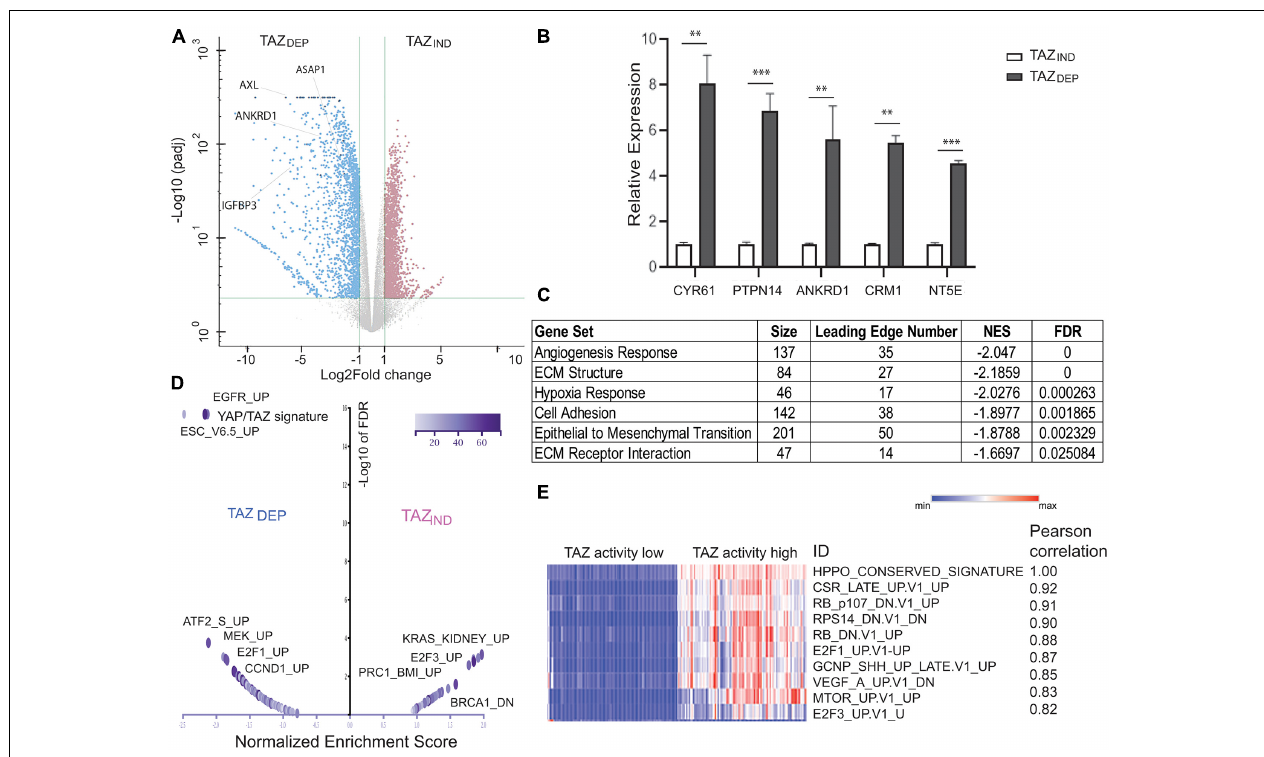
FIGURE 4 | Gene expression profiling for TAZ DEP and TAZ IND cells. (A) Volcano plot shows significant gene expression alterations between TAZ DEP and TAZ IND cells. (B) qRT-PCR experiment detection of canonical TAZ target expression in TAZ DEP and TAZ IND cells. Relative expression was normalized by GAPDH expression. Unpaired two-tailed Student’s t -test: ∗∗ p < 0.01; ∗∗∗ p < 0.001. (C) Over-representation analysis (ORA) using pathway annotations. (D) Volcano plot summarizes the normalized enrichment score (NES) for MSigDB oncogenic signature sets with direction for TAZ DEP vs. TAZ IND cells. (E) Correlation analysis of TAZ DEP and TAZ IND modules using TCGA Breast Invasive Carcinoma patient (RNASeqv2 RSEM) gene expression data. Top 10 pairwise Pearson correlations between TAZ activation and oncogenic gene signatures are summarized.